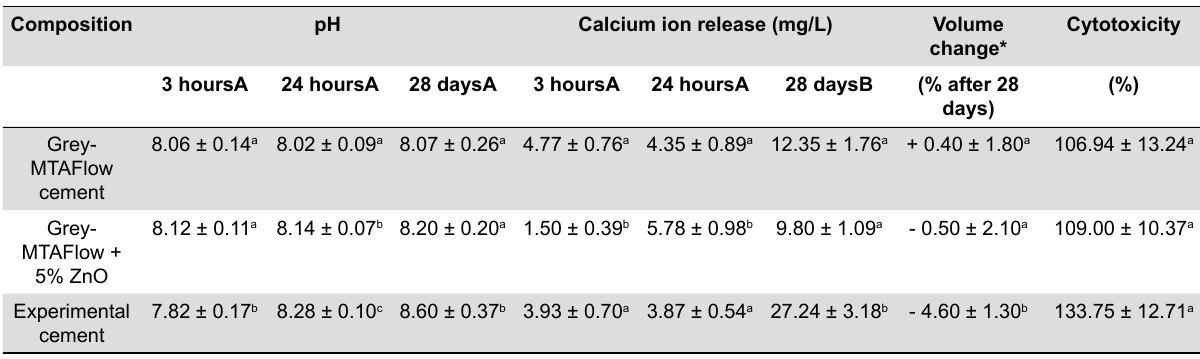
Table 3- Mean and standard deviation values of pH, calcium ion release, volume change, and cytotoxicity. Different letters in each column indicate statistically significant differences between tested materials (lowercase) and periods Composition